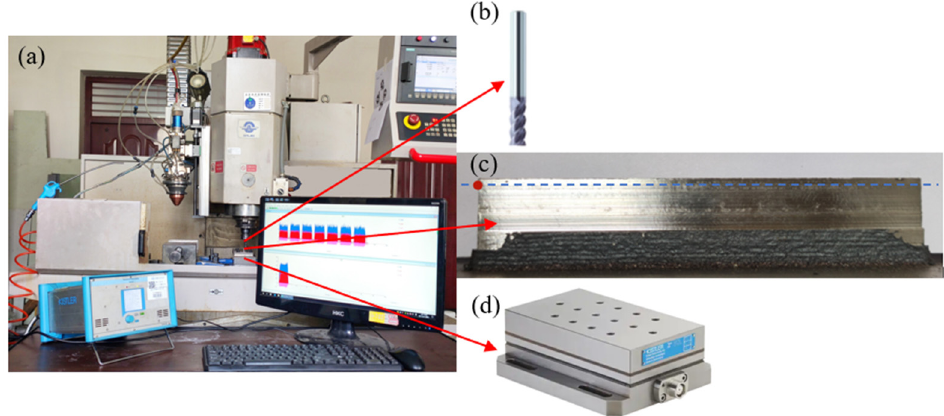
Figure 18. Side milling and force measurement of laser cladding thin-walled parts: ( a ) milling force measurement system; ( b ) GM-4E end mill; ( c ) thin-walled parts after milling; and ( d ) KISTLER triaxial